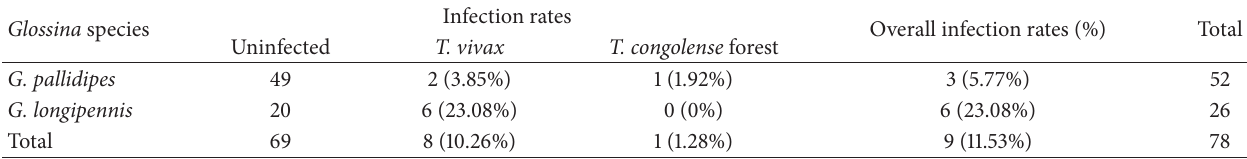
Table 3: Trypanosome infection rates in Glossina species.